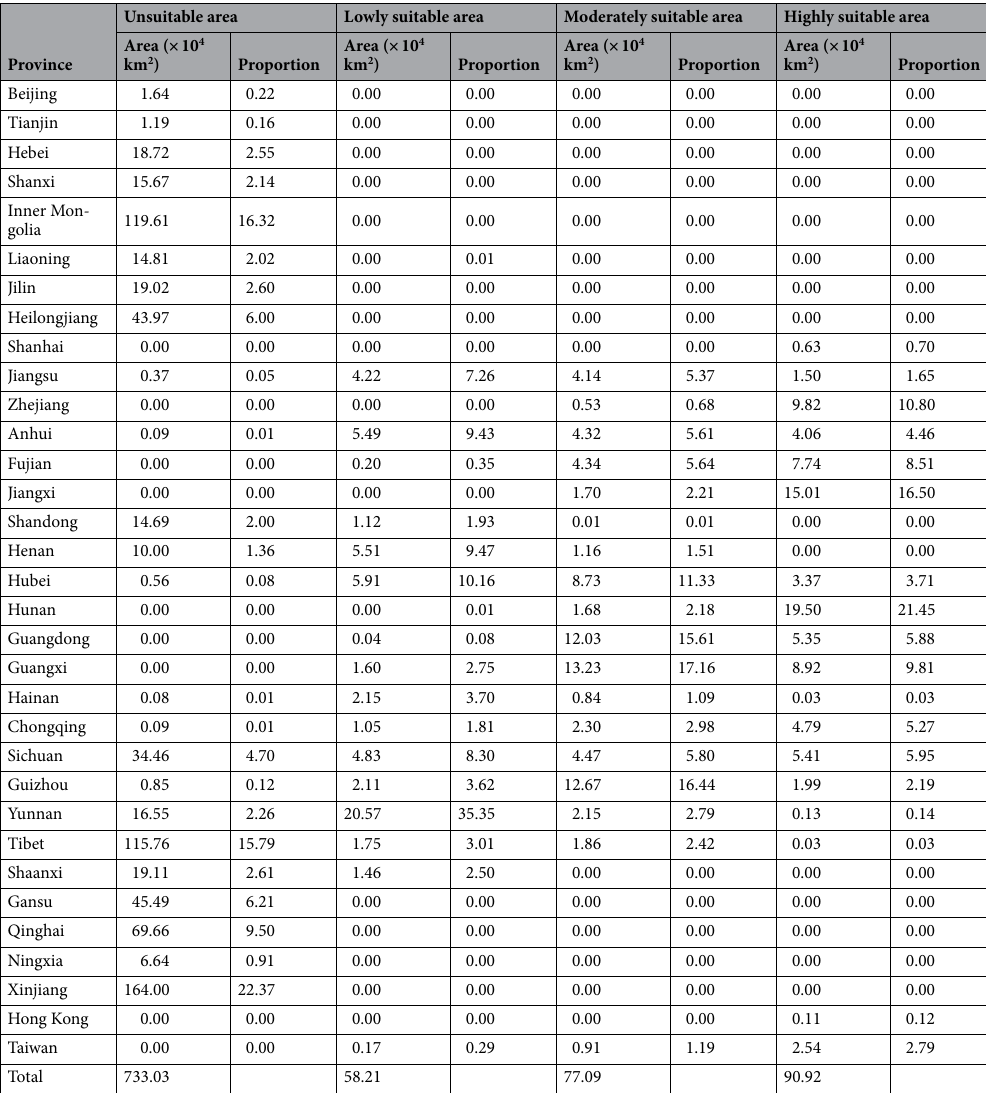
Table 2. Predicted areas for N. californicus under current climatic